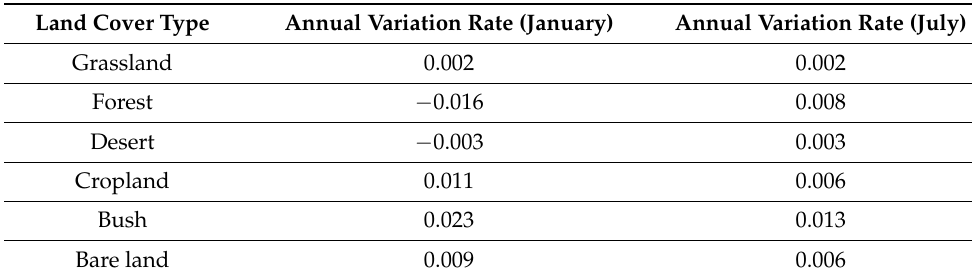
Table 6. Annual variation rate of surface albedo of different land cover types in January and July. Land Cover